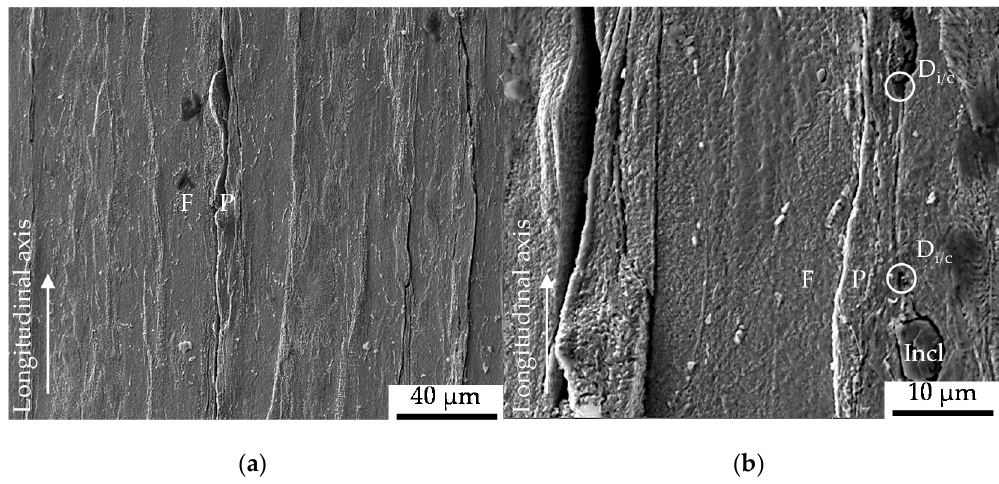
Figure 5. Cracks grown at the surface in axial direction after intermittent fatigue testing and surface etching with Nital 3% ( a ) overview indicating the crack localization within the ferrite (F) – pearlite (P) microstructure; ( b ) non-metallic inclusions (Incl) as part of the crack path and inclusion/matrix-decohesion assisted isotropic pore growth.